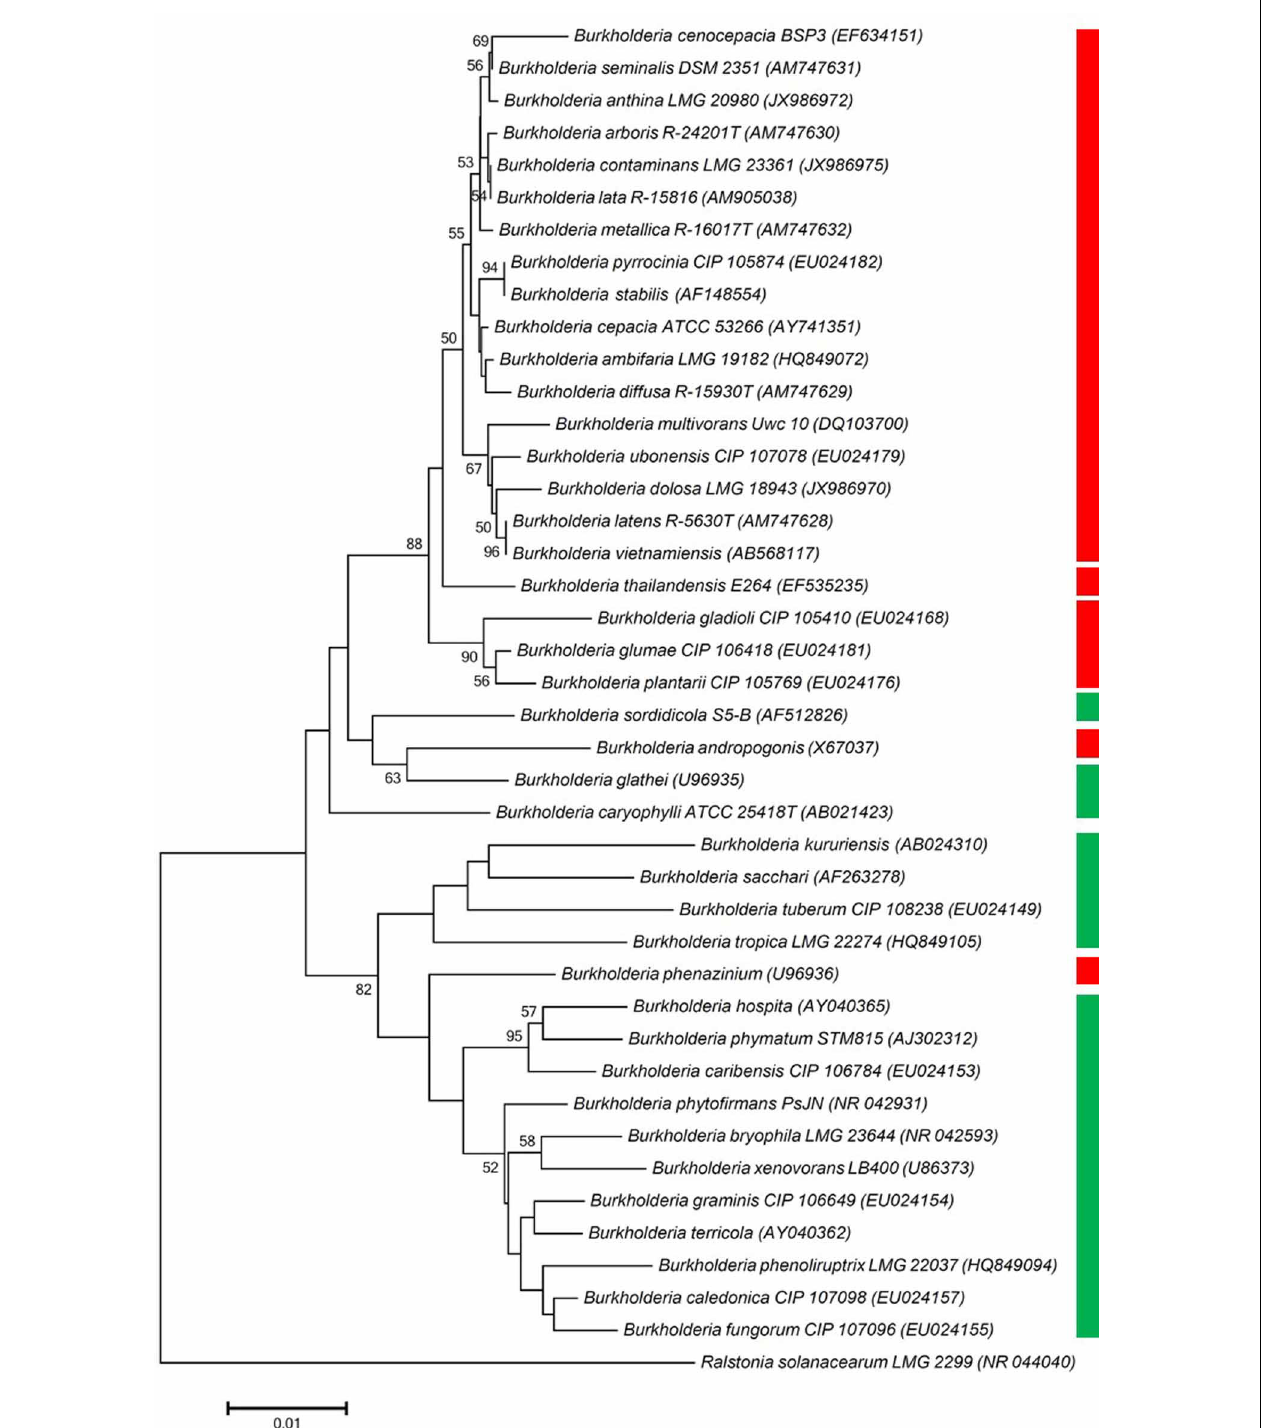
FIGURE 1 | Phylogenetic tree, constructed using one representative 16S rRNA gene sequence per Burkholderia species included in the oxalotrophy assay. Branches corresponding to partitions reproduced in less than 50% bootstrap replicates are collapsed. Only bootstrap values exceeding 50% are labeled. The percentage of